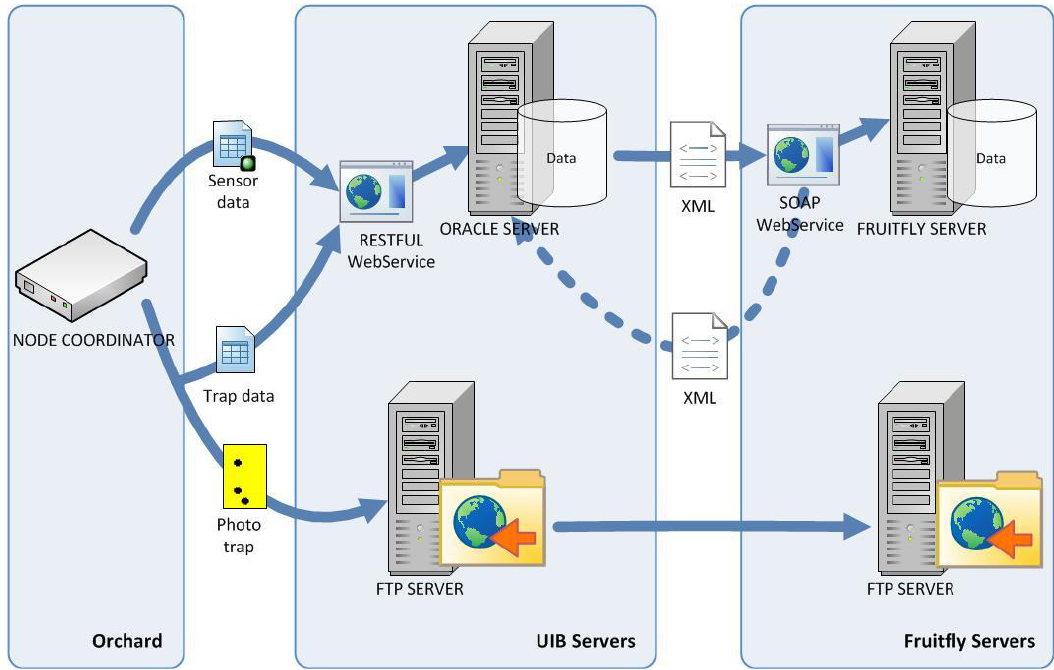
Figure 3. Architecture of the data transfer protocol from e-traps at orchard level to the servers at UIB and to the Fruitfly central servers.